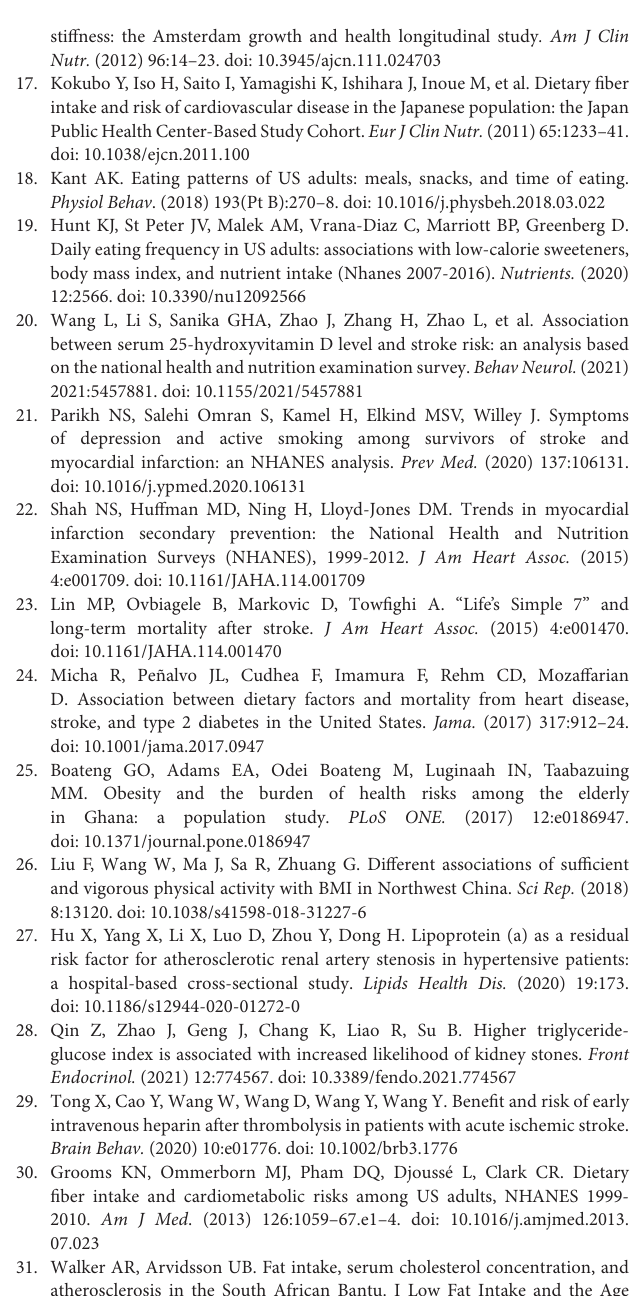
Supplementary Figure S1 | Flowchart of the total number of individuals with missing variables per study year from National Health and Nutrition Examination Survey (NHANES) 2011–2018.